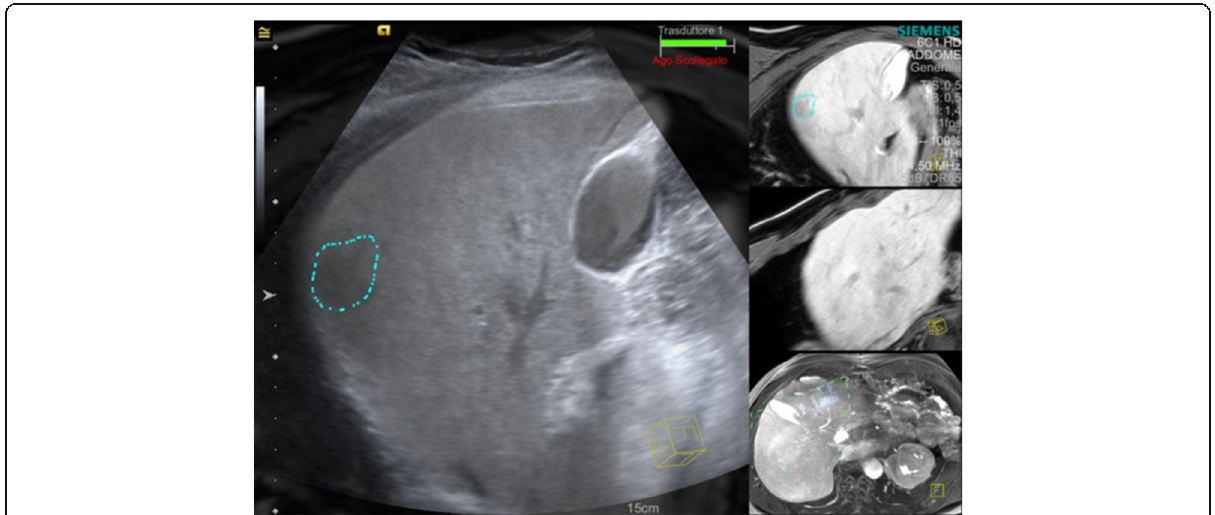
Fig. 2 MR-US fusion imaging. Biopsy of very small liver nodule, hypointense on the late hepatobiliary phase of MR, with a final diagnosis of a metastatic